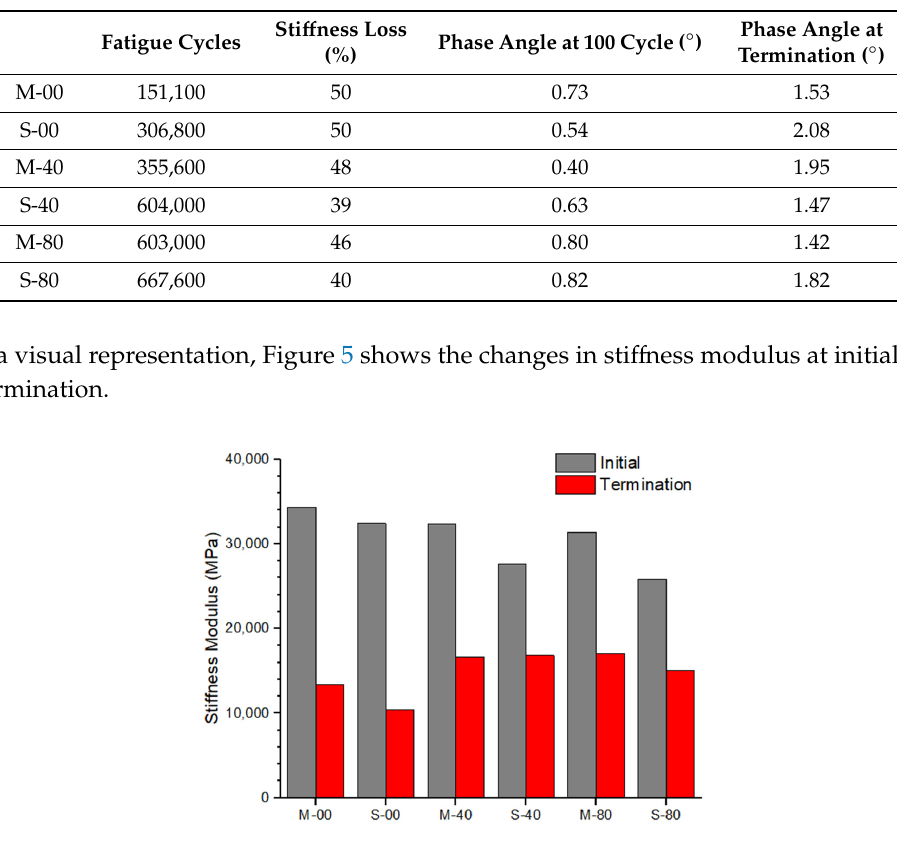
Figure 6. Average number of fatigue cycles to the end of the 4PB fatigue tests at either 50% stiffness modulus lost or 1 million cycles limit. Figure 7. Stiffness loss of rigid pavement specimens tested in 4PB fatigue tests.